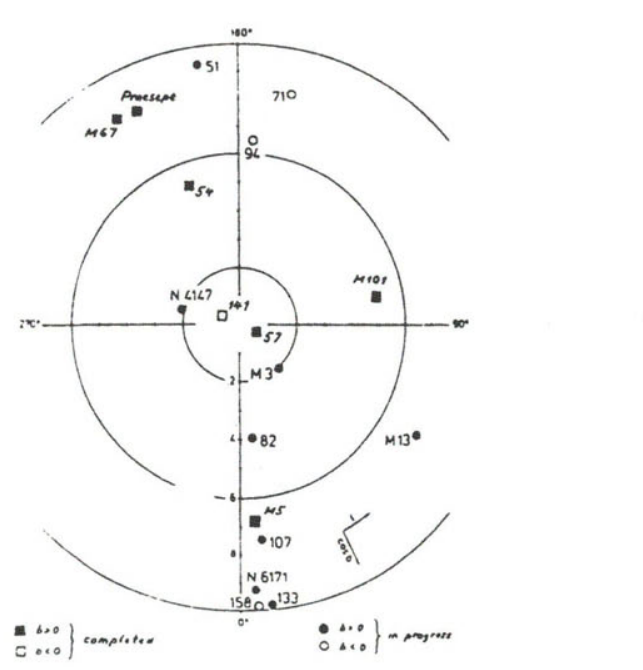
Fig. 1. The Basel high-latitude survey fields, with galactic coordi- nates projected onto the galactic plane.